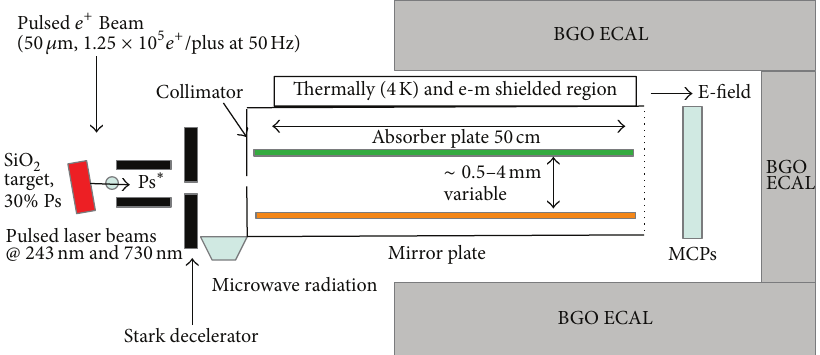
Figure 1: Scheme of the proposed experimental